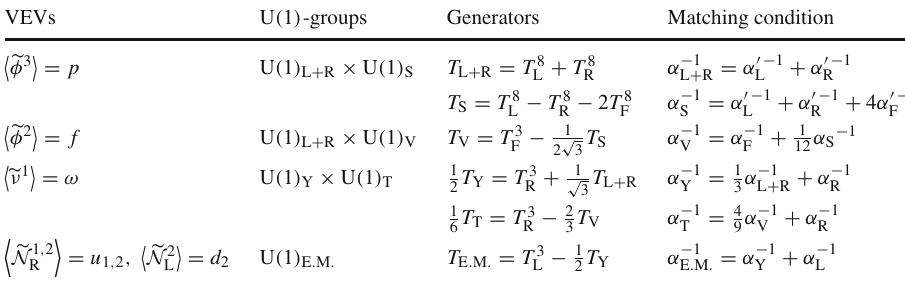
Table 11 Details of the abelian VEVs U ( 1 ) -groups Generators Matching sector of the SHUT model